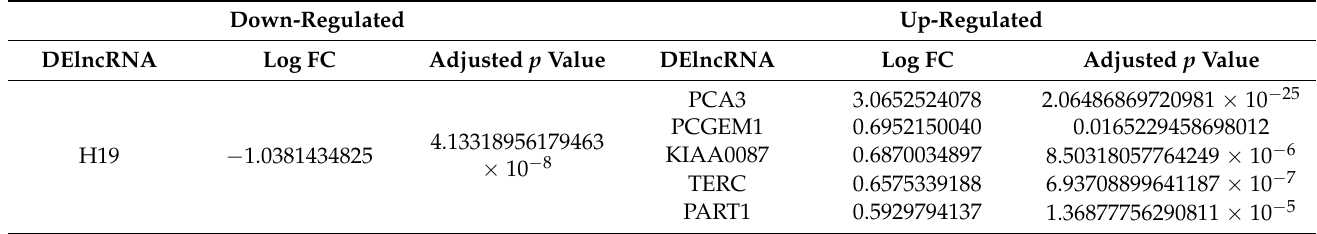
Table 3. The up- and down-regulated DElncRNAs between prostate and normal samples.